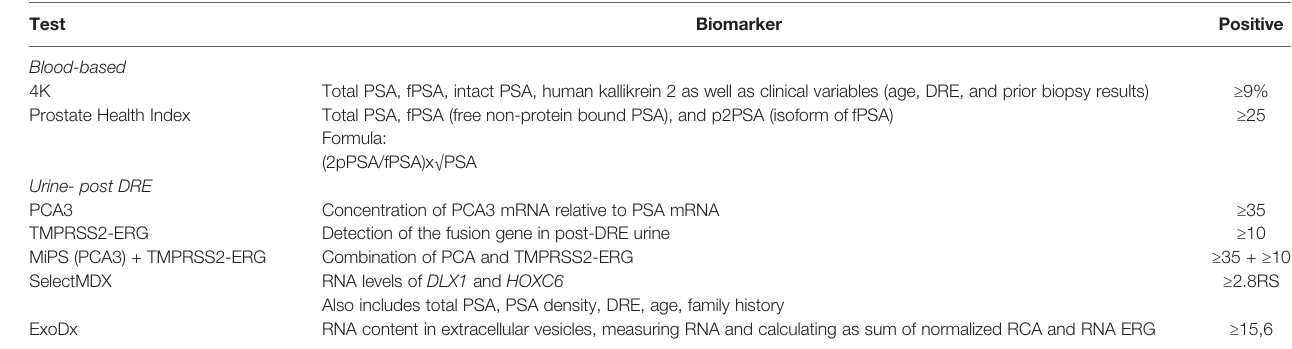
TABLE 1 | Biomarkers for prostate cancer